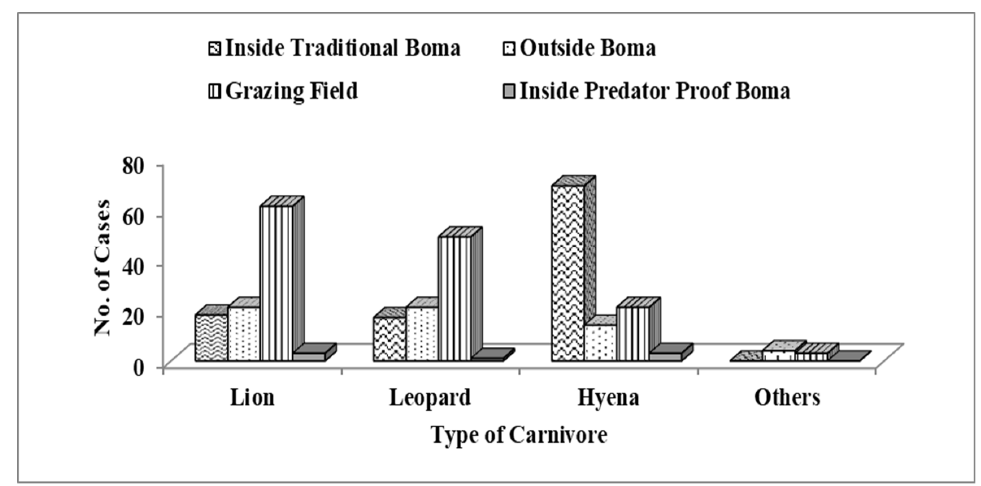
Figure 5. Distribution of livestock depredation incidences in relation to the location of attack and carnivore species